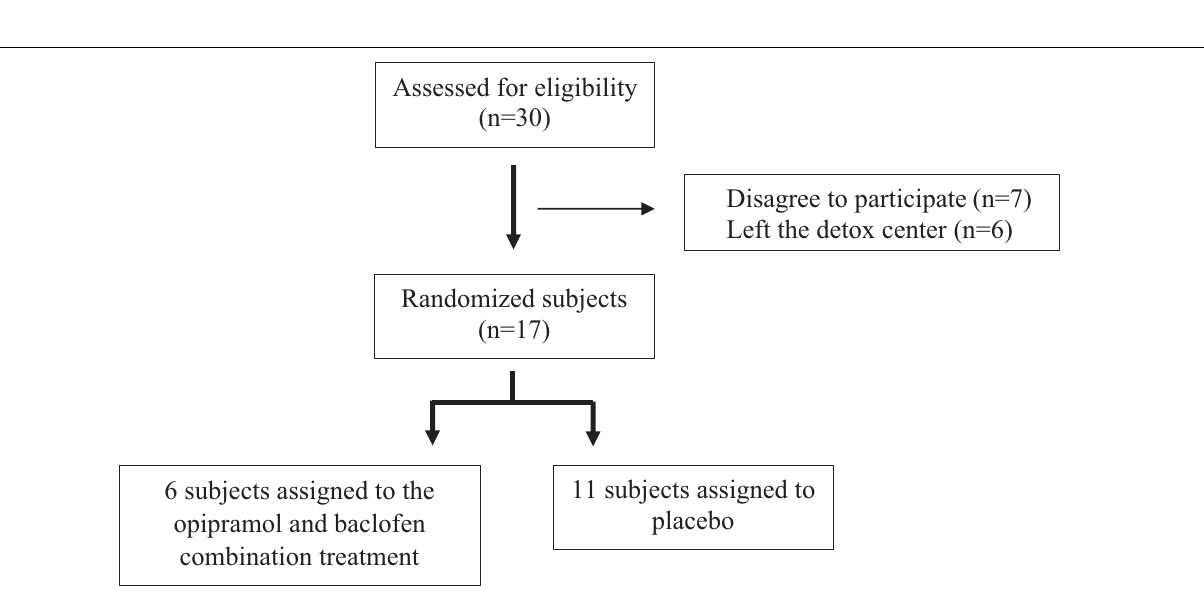
Frontiers in Behavioral Neuroscience |